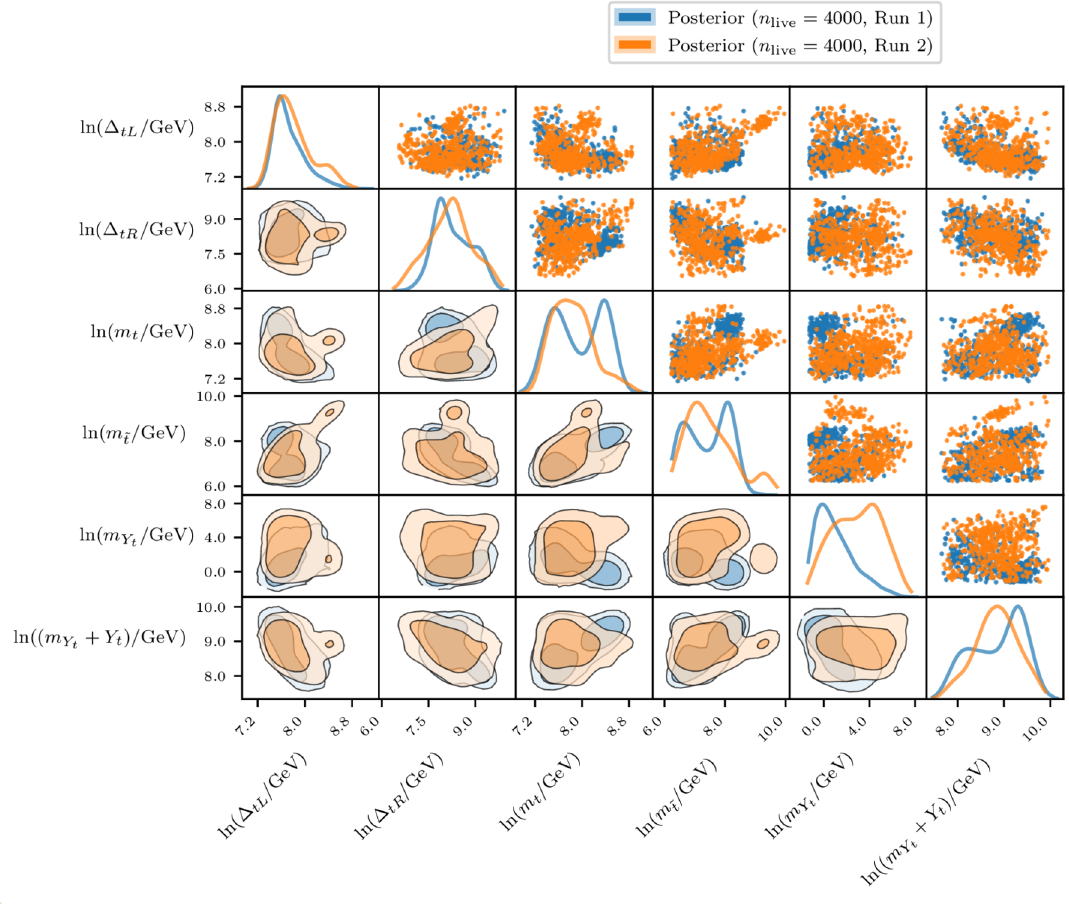
Figure 19. 1D and 2D marginalised posteriors for the top partner parameters in the M4DCHM 5 − 5 − 5 found in two different runs with 4000 live